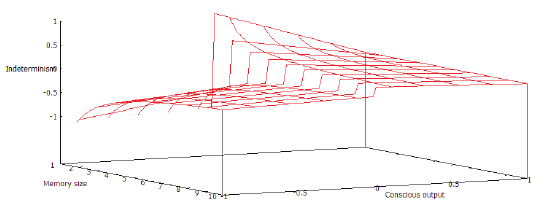
Fig. 16. Dynamics of consciousness and indeterminism with memory